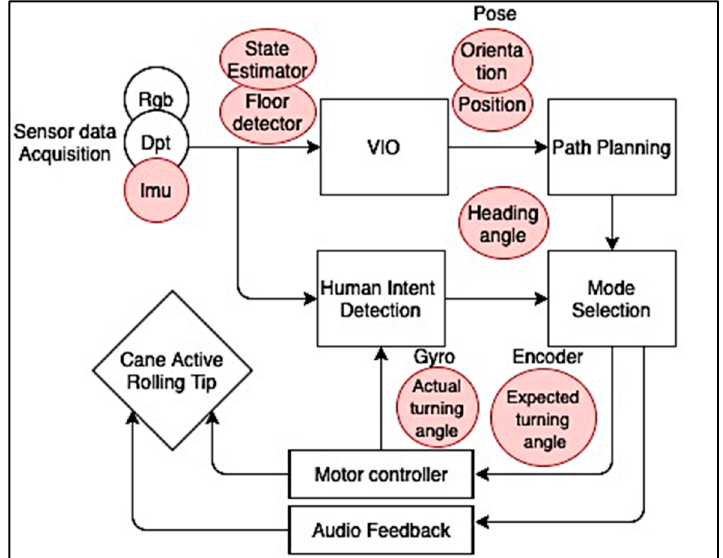
Figure 3. Adaptation diagram from the Robotic Navigation Aid system proposed by [89].